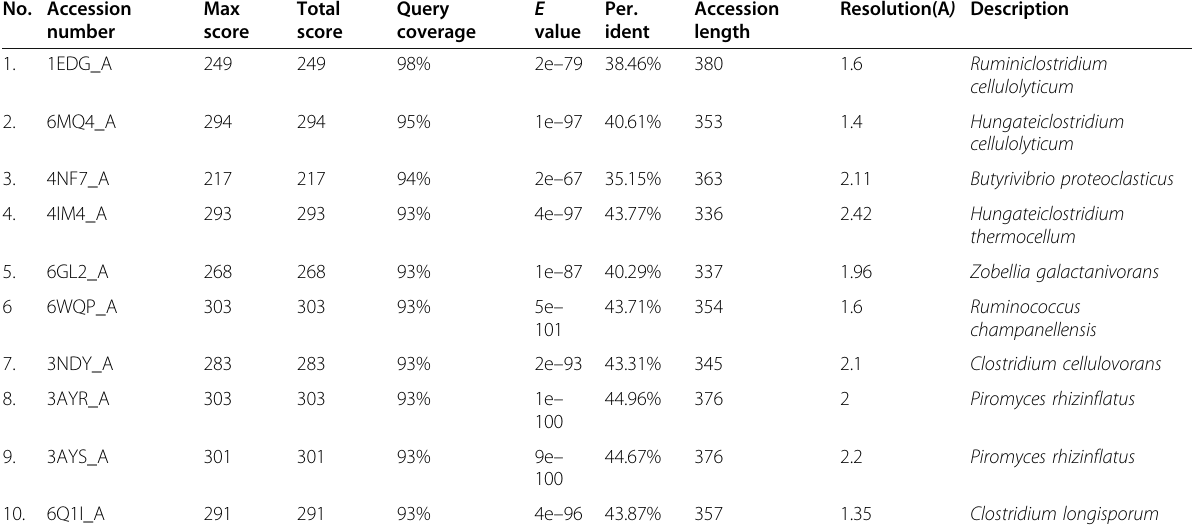
and relative (.) conservation regions. Also, query se- quence (P2360) and 10 template sequences are aligned